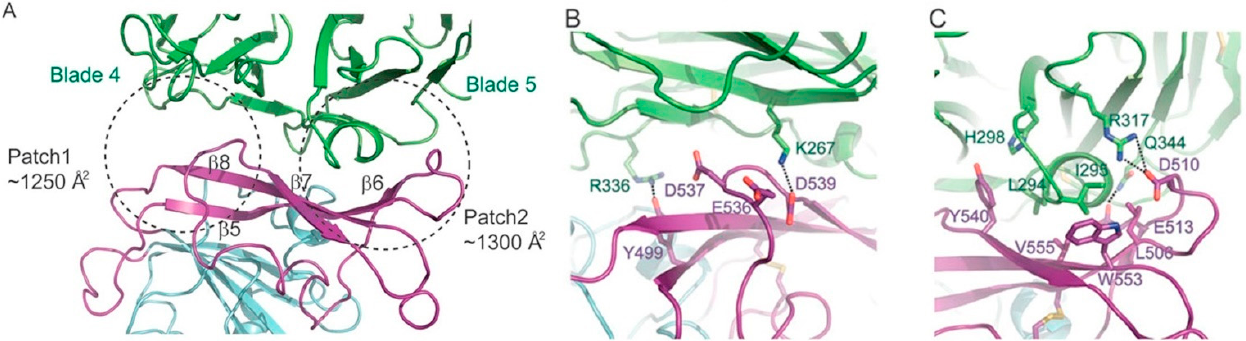
Figure 1. Binding interface of MERS-CoV-DPP4 in the crystal structure of their complex (PDB entry 4L72). ( A ) Overview of the binding regions between DPP4 (green) and MERS-CoV (cyan). The RBM of MERS-CoV (purple) is highlighted. ( B , C ) Key DPP4 and MERS-CoV binding residues. Image taken from Wang et al. [6]. Licensed under the Creative Commons Attribution-Non-Commercial-No Derivative Works 3.0 Unported License.